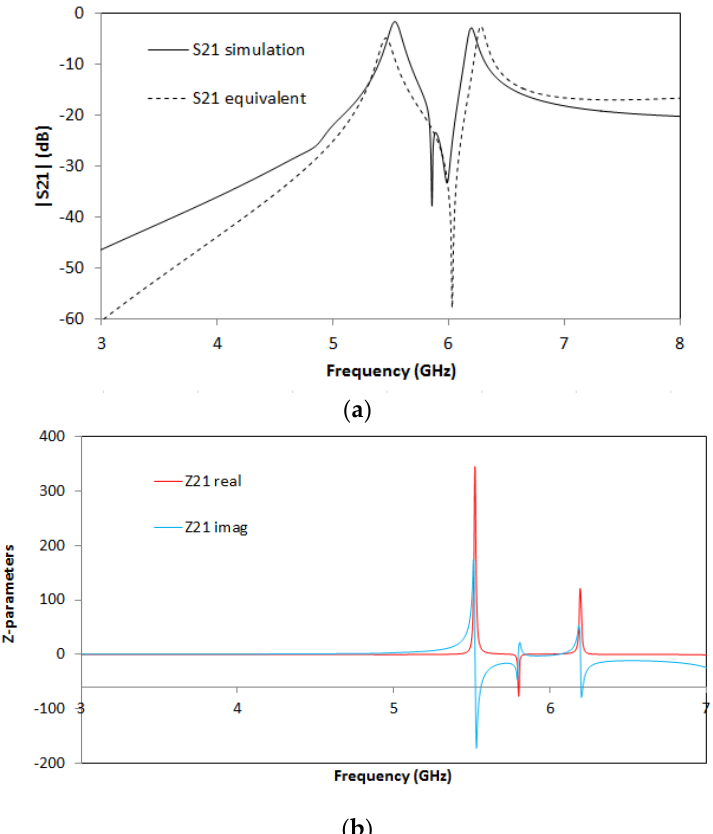
Figure 17. ( a ). Simulated S21 (solid black line), simulated S21 for the equivalent circuit model (dashed black line). ( b ) Impedance graph: Z21 real part (solid red line), Z21 imaginary part (solid blue line).